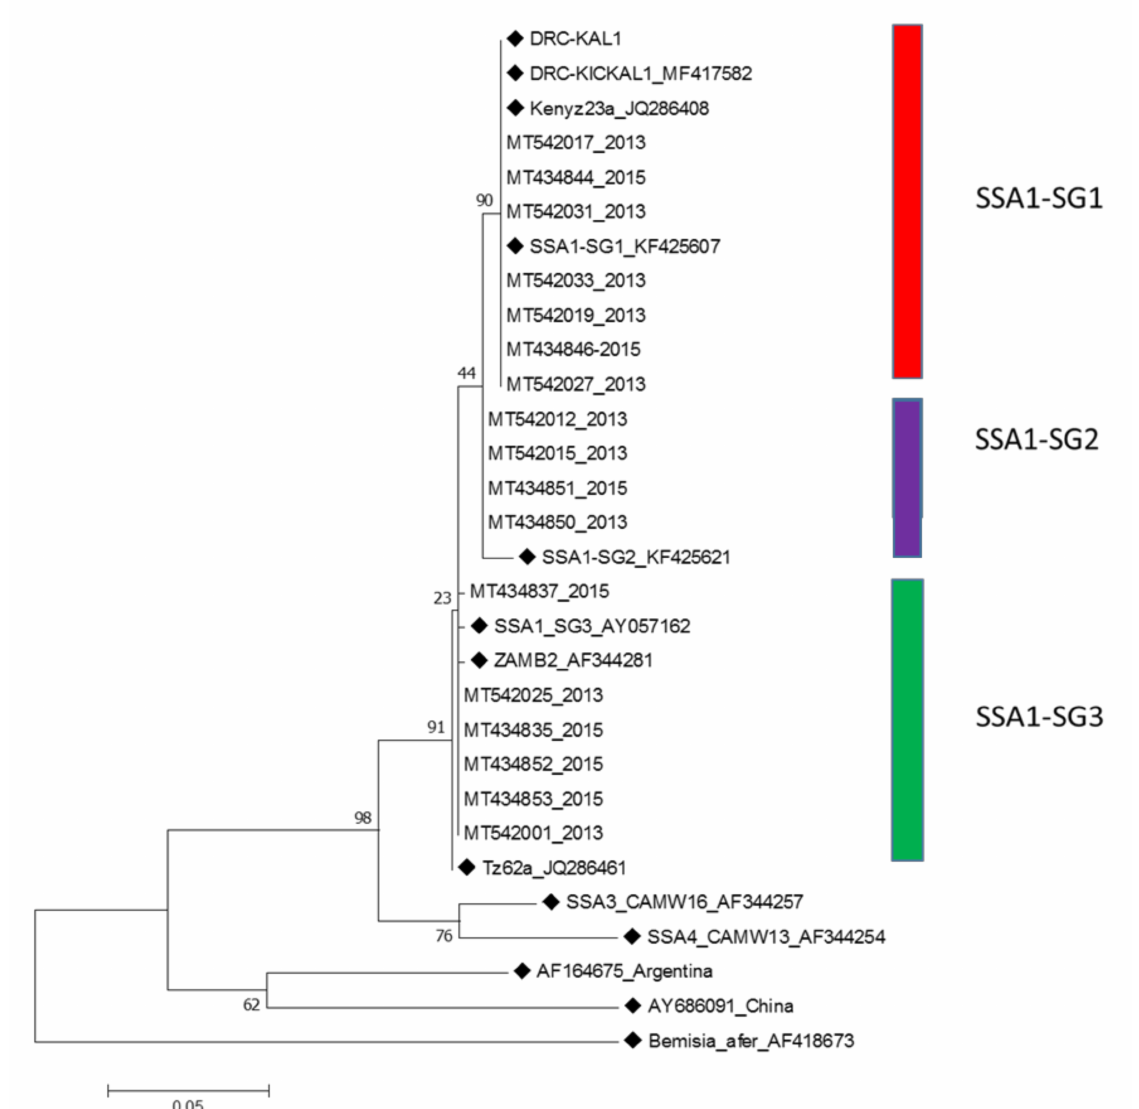
Figure 2. Maximum-likelihood phylogenetic tree constructed using mitochondrial cytochrome oxidase I sequences obtained from Bemisia tabaci collected on cassava in Zambia in 2013 and 2015. The tree is based on the Hasegawa-Kishino-Yano model with discrete gamma distribution (HKY + G + I) and 1000 bootstrap replications. Reference sequences from the National Center for Biotechnology Information are indicated with squares for comparison. Bemisia afer (AF418673) is included as an outgroup sequence. The numbers placed at each node indicate the bootstrap support for values >